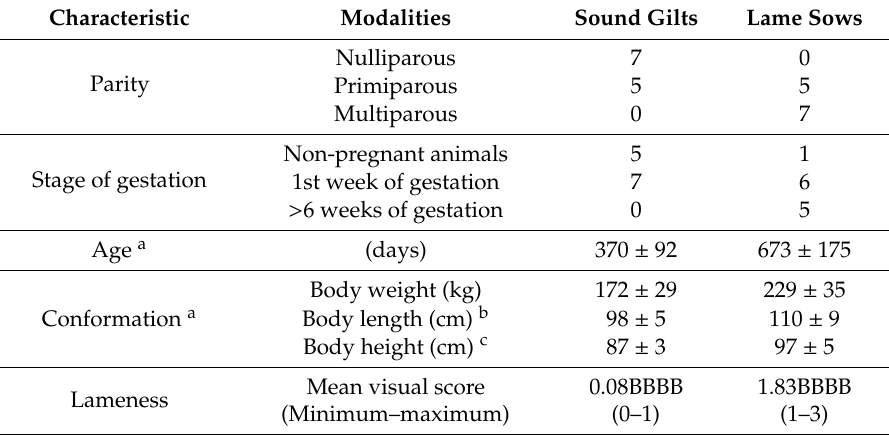
Table 1. Characteristics of the groups of animals tested: sound gilts (n = 12) and lame sows (n = 12). Characteristic Modalities Sound Gilts Lame Sows Nulliparous 7 0 Parity Primiparous Non-pregnant